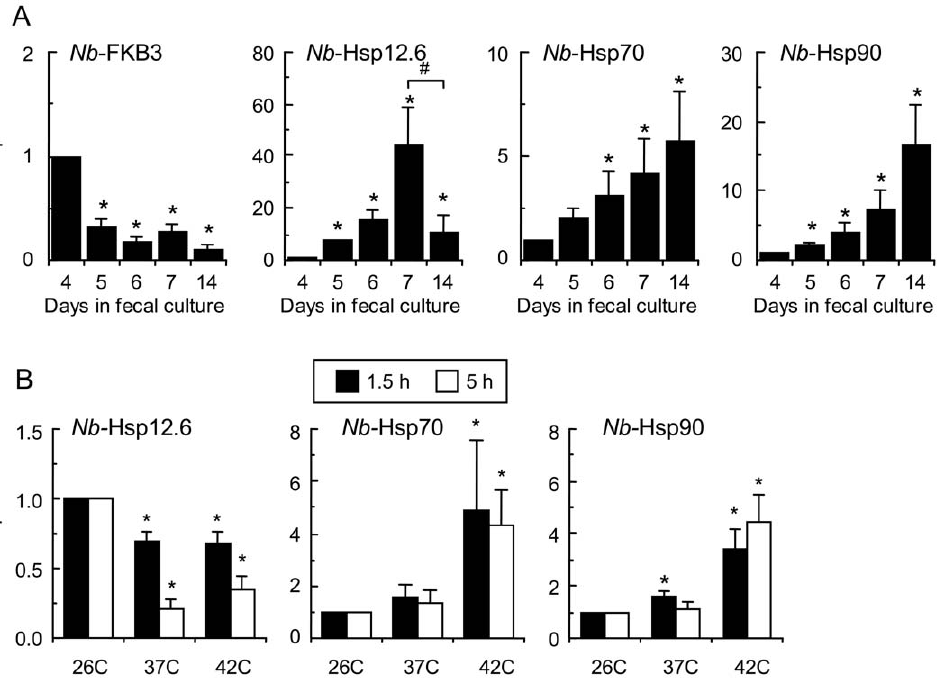
Figure 7. Hsp gene expression in the pre-parasitic stages of N.brasiliensis . A . Temporal gene expression patterns of larvae during 4 to 7 days fecal culture at 26 u C. Levels at 4 days fecal culture are expressed as 1.0. Data shown are the mean and SD of larval populations from 4 fecal cultures derived from 4 host animal feces. * P , 0.05 compared with the levels in 4 day-old fecal culture. B . Heat shock responses of infective L3 larvae. Infective-L3 larvae in 7 day-old fecal culture (26 u C) were incubated at 37 or 42 u C for 1.5 or 6 hours. The expression levels in the larvae incubated at 26 u C are expressed as 1.0. Data shown are the mean and SD of larvae from 4 fecal cultures derived from 4 host animal feces. *Significantly different from the levels of larvae incubated at 26 u C ( P , 0.05).